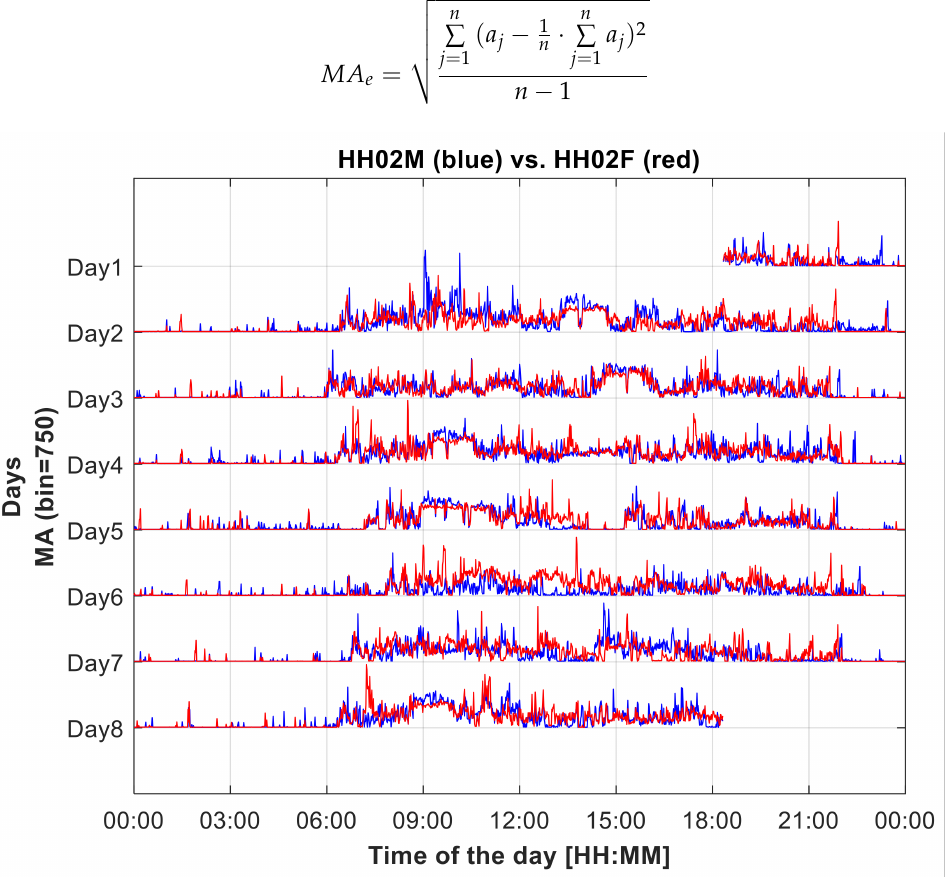
Figure 1. Synchronized plots of the week-long MA profiles of the two subjects (HH02M, male, in blue, and HH02F, woman, in red) belonging to a married couple. The CC value between them is 0.58, the highest value observed in the study, marking a relevant coupling, noticeable in the common wake-up time, frequent phases of common MVPA, and common sleeping